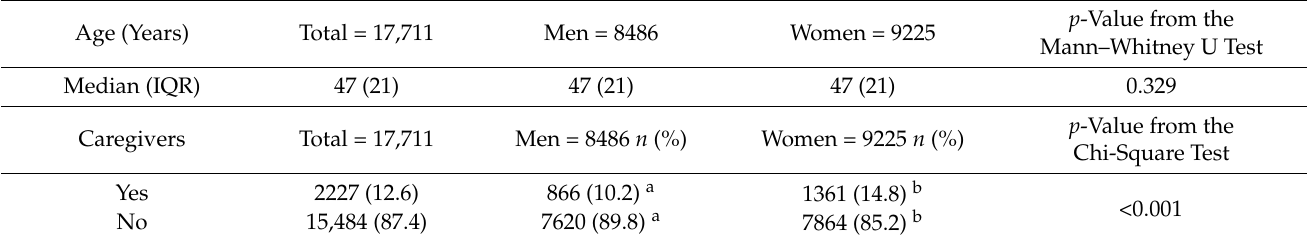
Table 1. The age and number of caregivers according to the Spanish National Health Survey 2017.